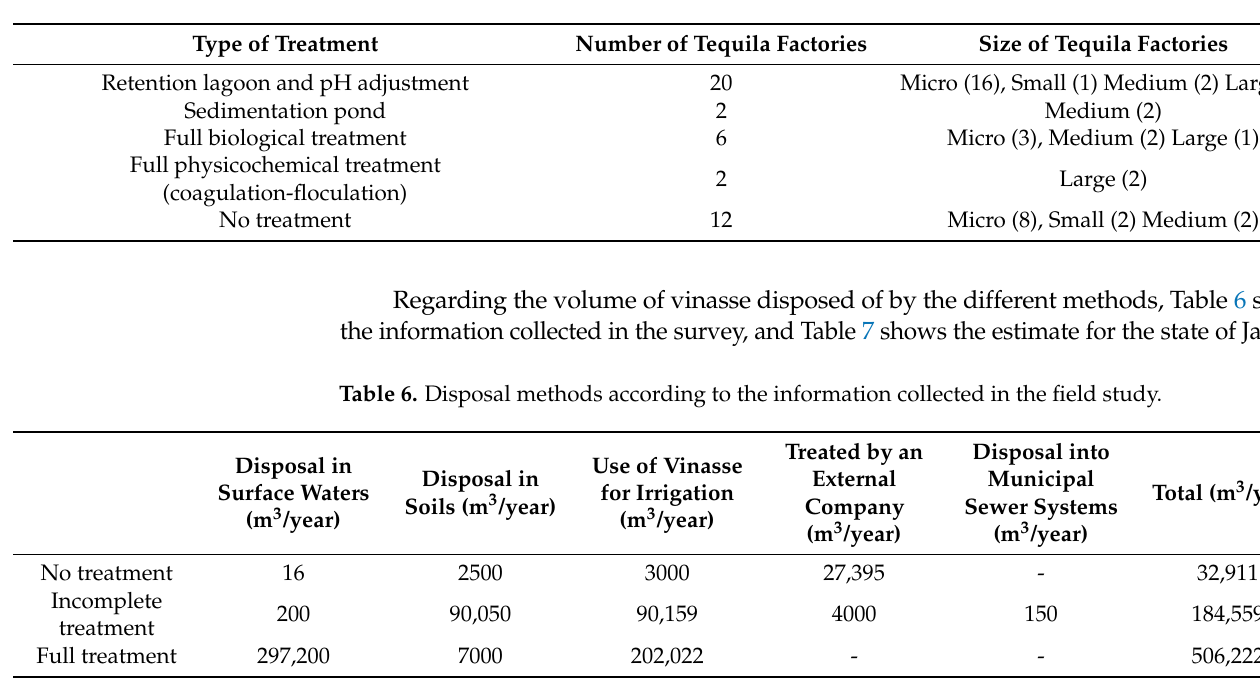
Table 5. Treatments given to vinasses in tequila factories.